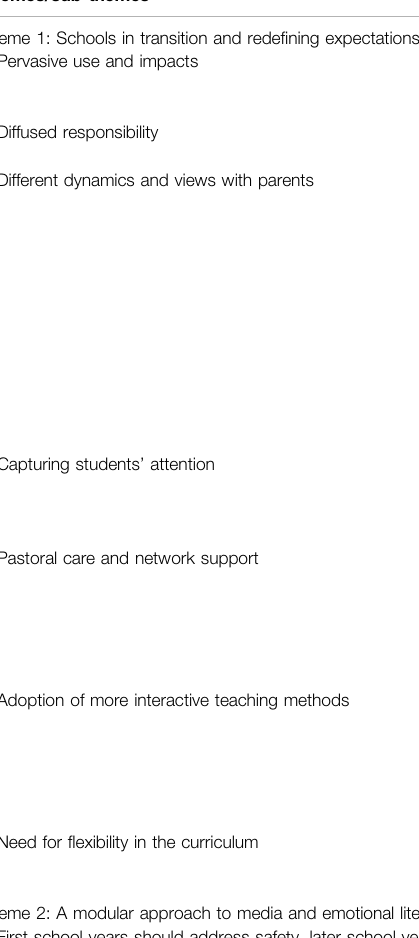
TABLE 1 | Teachers ’ Perceptions and recommendations for online challenges and harms